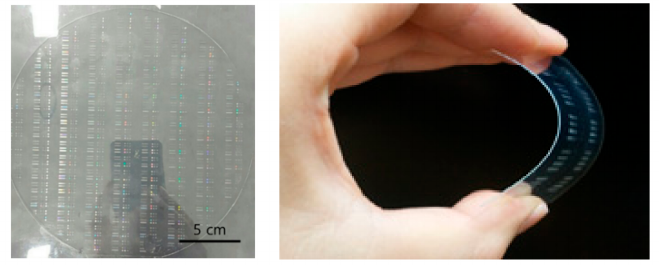
Figure 2. Fabricated flexible clich é using UV-curable resin by the NIL process.